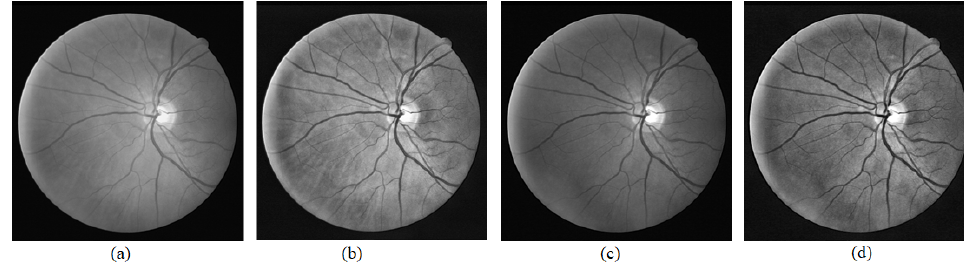
Figure 14. Green channel extraction and CLAHE on Photo 2 . ( a ) Grayscale image. ( b ) CLAHE on grayscale image. ( c ) Extracted green channel. ( d ) CLAHE on extracted green channel.